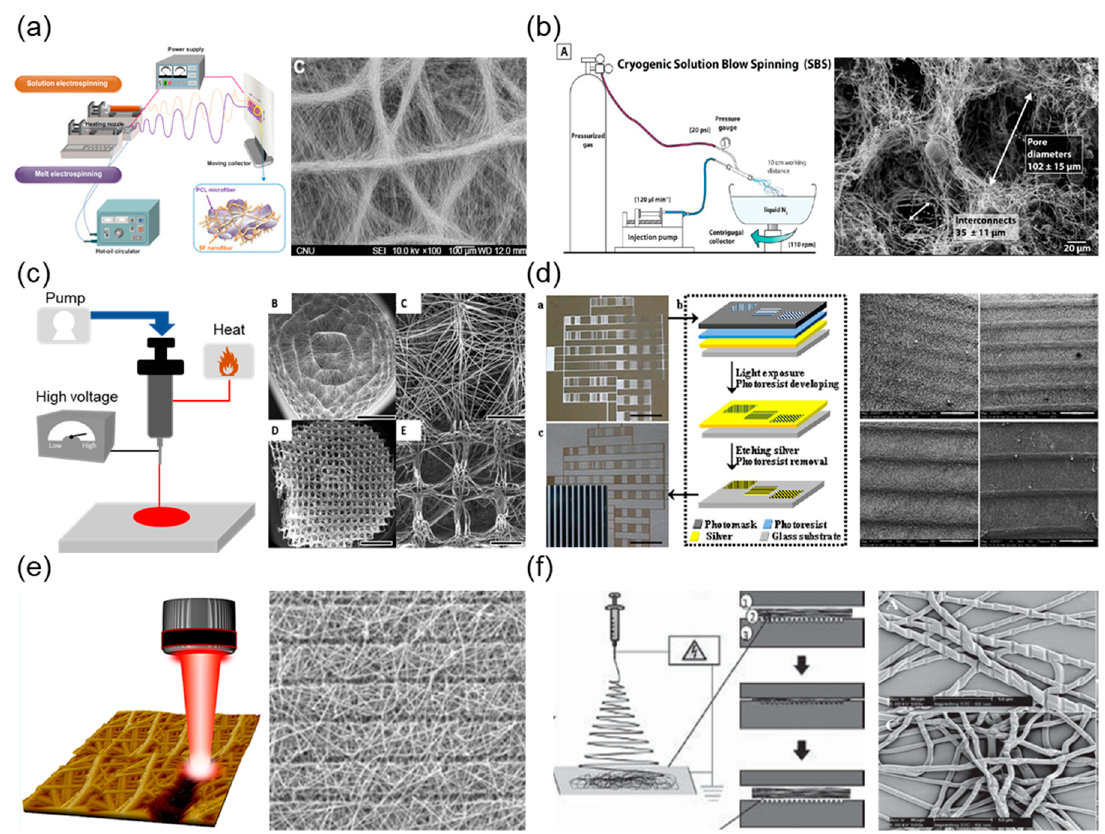
Figure 2. Techniques to control geometry in fibrous scaffolds and representative images. Schematic setup for (a) dual extrusion electrospinning [40]: ( b ) cryogenic electrospinning [41]; ( c ) melt electrospinning [42]; and ( d ) micropatterned collector-based electrospinning [43]. Schematic illustration of post-processing techniques using ( e ) laser-based ablation [44] and ( f ) nanoimprinting lithography [45].